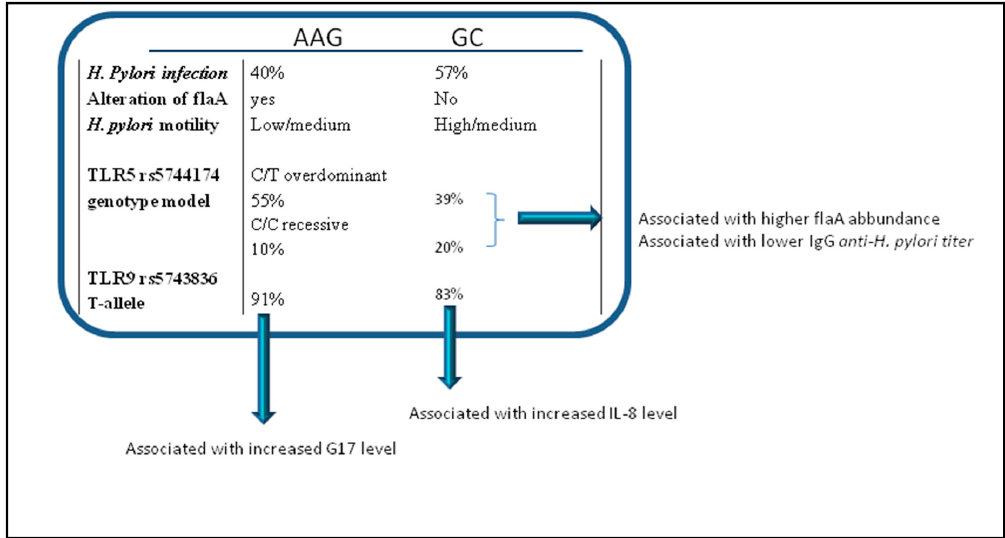
Figure 7. An abridged form of the different characteristics we observed in AAG and GC.